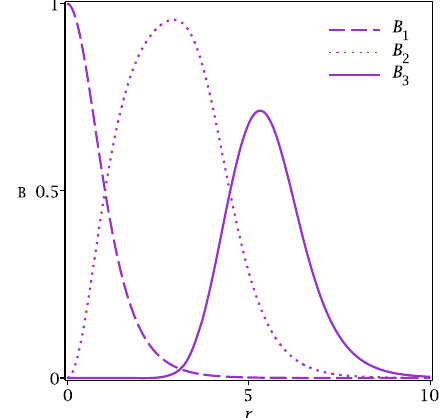
Fig. 2 Magnetic inductions from sectors 1, 2 and 3, for the model defined by (26) with n 1 = 1, n 2 = n 3 = 10